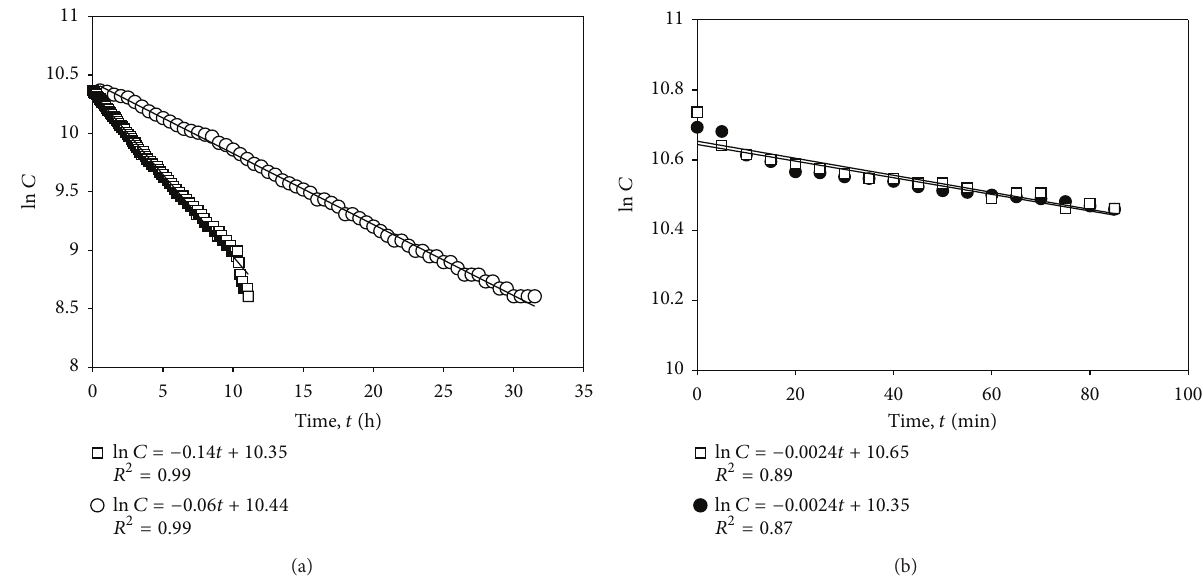
Figure 3: Test of fluorometer controlled apparatus (FCA). (a) Two examples of exponential decrease in algal concentration ( 𝐶 0 = around 40,000 cells mL −1 ) in experimental aquarium ( 𝑉 = 15.4 L) caused by flow-through of biofiltrated seawater ( ◻ , 2.1 and ⃝ , 1.2L h −1 ) diluting the algal concentration measured by fluorescence. The slopes of the regression lines in the semi-ln plot express the flow-through rate, compare (1). (b) Exponential decrease in algal concentration in aquarium caused only by filtering mussels (mean ± S.D., shell length = 28.0±1.3 mm). The algal concentration was measured using both an electronic particle counter ( ∙ ) and the FCA ( ◻ ). The slopes of the regression lines express the filtration rate of the mussels ( 𝑛 = 8 , ◻ and ∙ = 0.3 L h −1 ), compare (1).